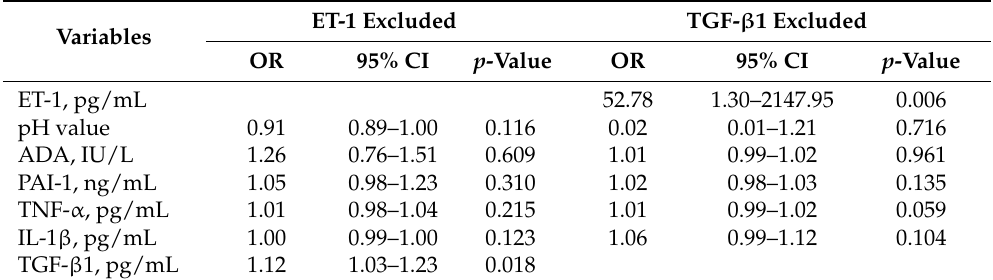
Table 4. Multivariate logistic regression analyses of factors associated with RPT >10 mm among TBPE patients ( n =